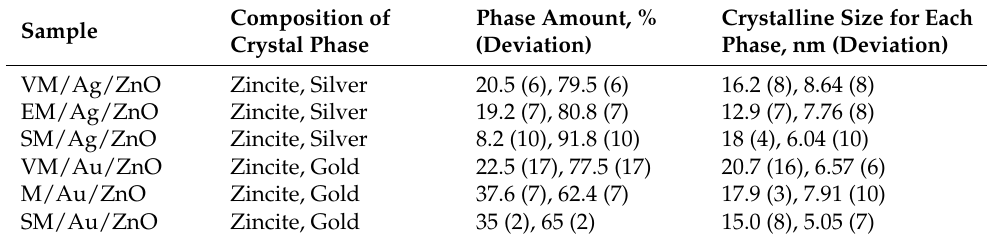
Table 1. The results of XRD studies of heterodimers.